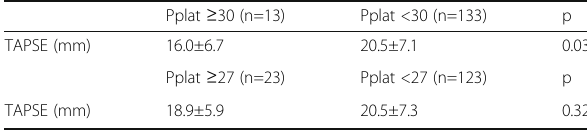
Table 1 (abstract 0338). Differences in TAPSE, based on Pplat